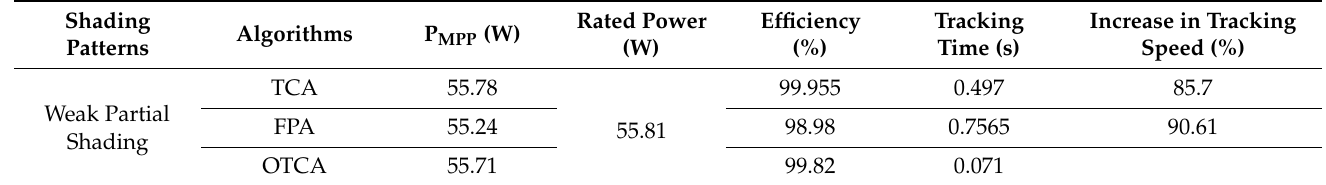
Table 4. Performance comparison of FPA, TCA, and OTCA algorithms under weak partial shading.